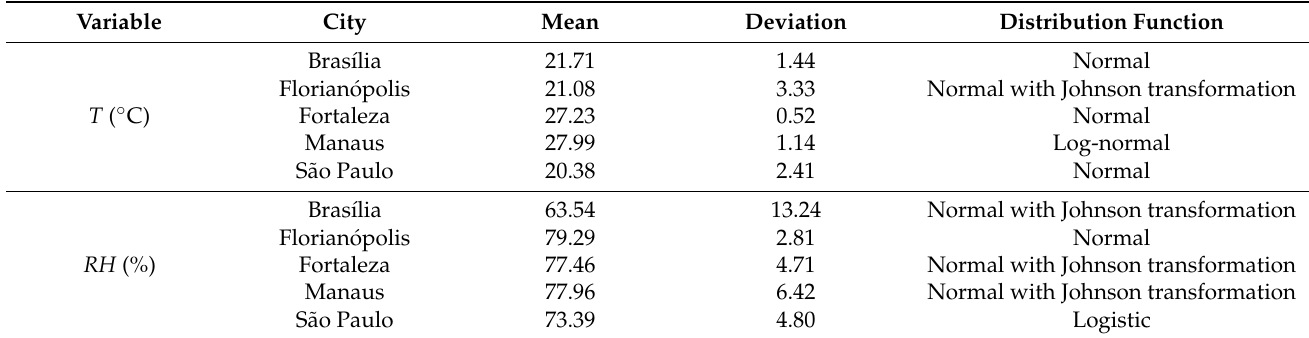
Table 5. Statistical parameters of average monthly temperature and humidity. Deviation Distribution Function